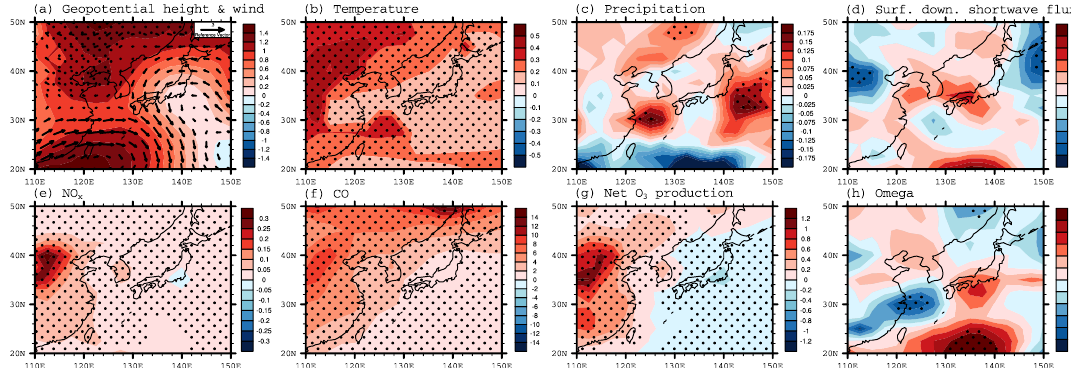
Figure 3. The regression fields between PC1 and ( a ) geopotential height (shaded; m) and horizontal wind (vector; m s − 1 ), ( b ) temperature (K), ( c ) precipitation (mm day − 1 ), ( d ) surface downwelling shortwave flux (W m − 2 ), ( e ) nitrogen oxides (ppbv), ( f ) carbon monoxide (ppbv), ( g ) net ozone production rate ( × 10 − 12 mole m − 3 s − 1 ), and ( h ) 500 hPa omega (hPa day − 1 ) during summer. Note that all variables except ( c – h ) are for an 850 hPa level. Black dots indicate statistical significance at 90% confidence level using a Student’s